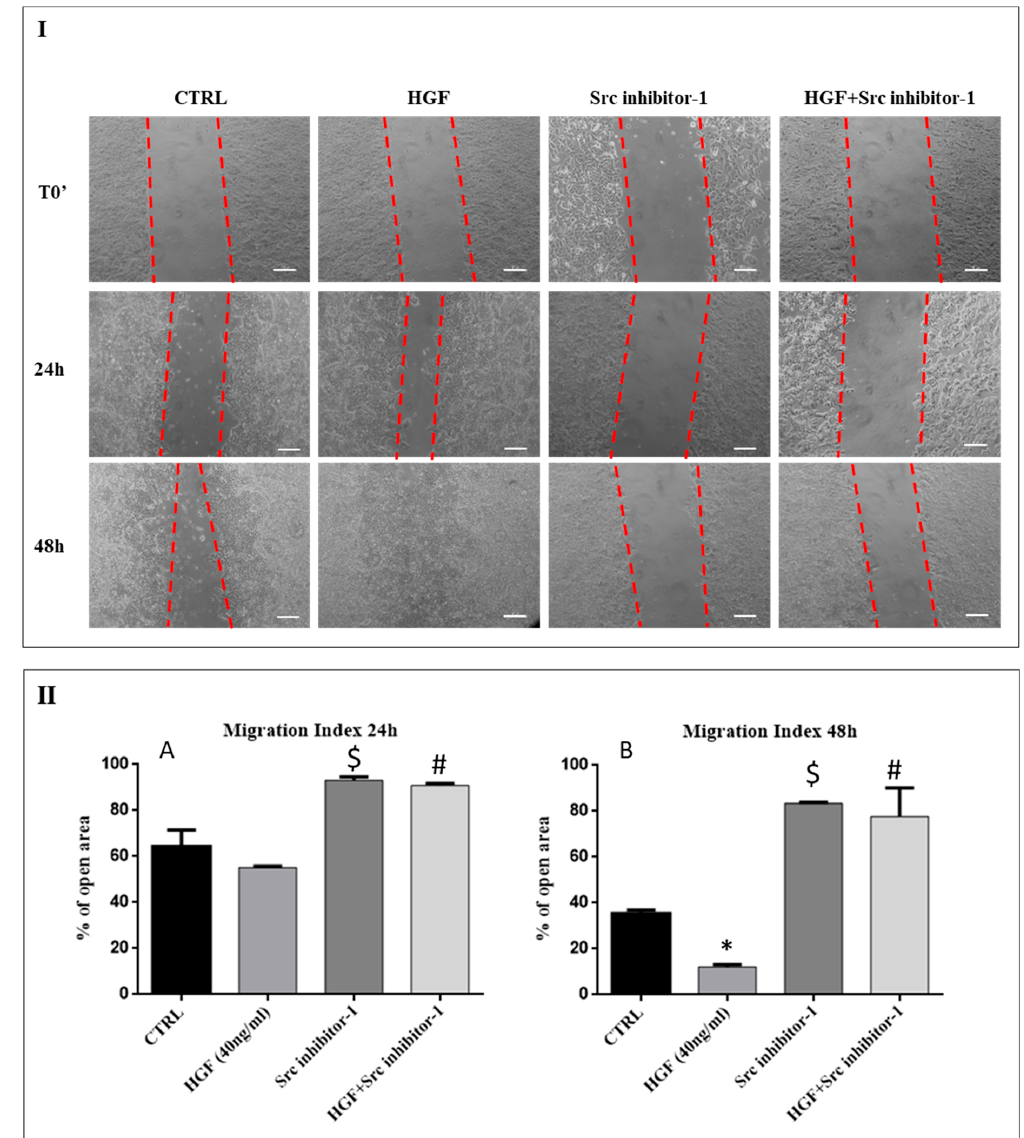
Figure 5. Effect of Src Inhibitor-1 on NT2D1 cell collective migration: Wound-healing assay on NT2D1 cells cultured in DMEM + 2% FBS alone (CTRL), or added with HGF, Src inhibitor-1 or HGF+Src inhibitor-1. Four inserts were used for each experimental condition in each experiment. The experiment was performed in triplicate. (I) Representative phase-contrast images of wound-healing assay taken immediately after insert removal (T0) for wound gap (dotted red lines) measurement, or taken 24 h and 48 h after wounding. Images were photographed at 10 × magnification (scale bar: 100 µm). (II) Quantitative analysis of wound closure after 24 h ( A ) and 48 h ( B ) from insert removal. Data are expressed as the mean percentage of open residual area compared with the respective cell-free gap at T0. After 24 h the difference of open residual area between CTRL and HGF treated wells was not statistically significant. However, after 48 h of culture the decrease of open area in HGF treated wells was statistically significant with respect to the control wells (* p < 0.001). Src inhibitor-1 in combination with HGF both at 24 h (# p < 0.01) and 48 h (# p < 0.001) abrogated the migratory effect induced by HGF. Src inhibitor-1 alone was also able to inhibit the basal collective migration of the NT2D1 cells, compared with control wells, both at 24 h ($ p < 0.05), and 48 h ($ p < 0.001) after insert removal.